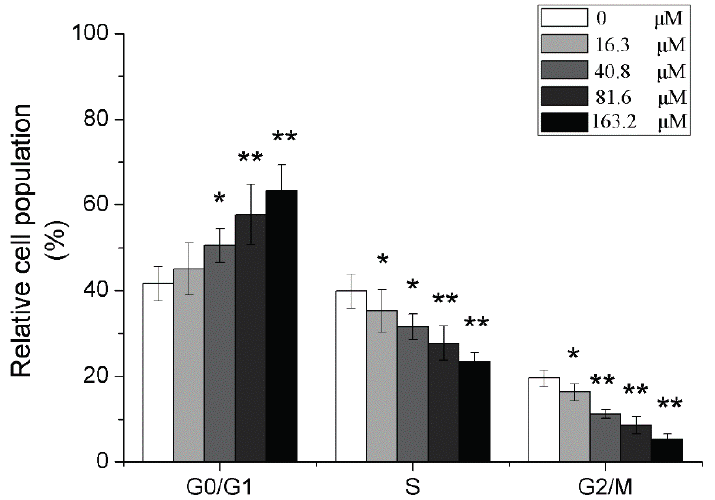
Figure 6. The effect of PD on the cell cycle in U251 cells. U251 cells were treated with 0, 16.3, 40.8, 81.6 and 163.2 μ M of PD for 48 h. Then they were stained with PI for flow cytometric analysis. Each value is presented as mean ± SD ( n = 3). * p < 0.05 compared with 0 μ M PD; ** p < 0.01 compared with 0 μ M PD.